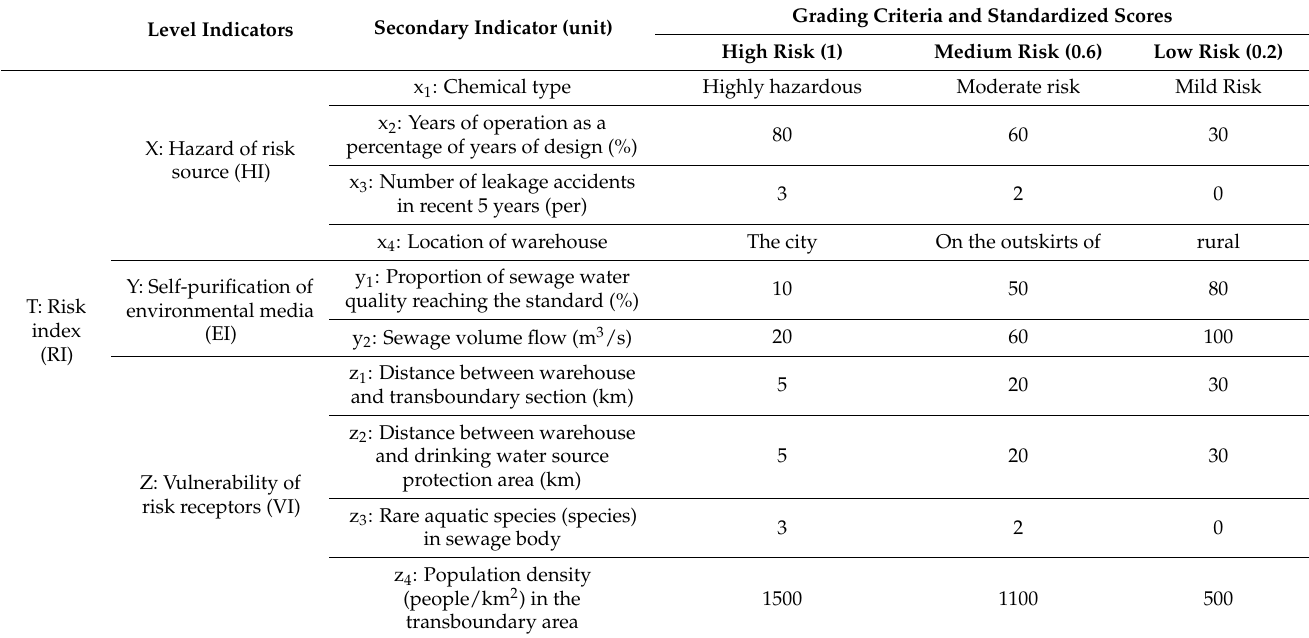
Table 4. Risk assessment index system for chemical storage sites in cross-border zones.